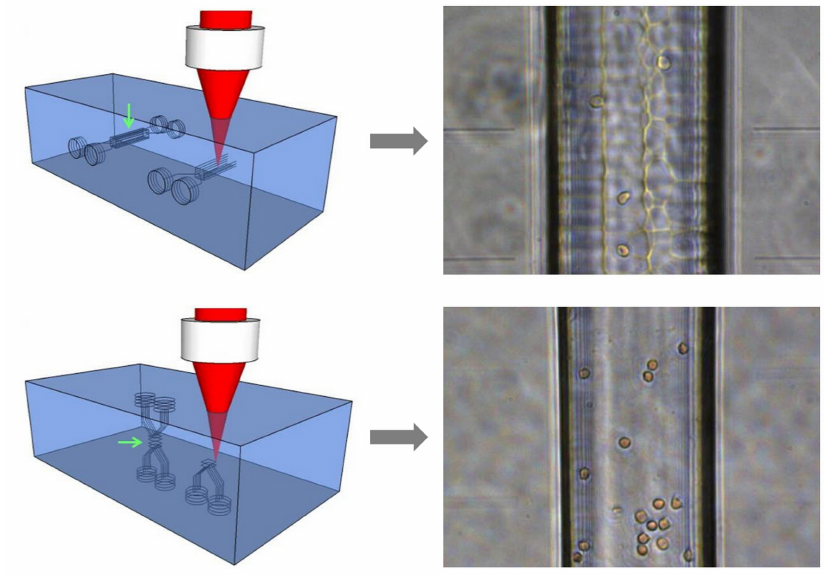
Figure 17. Laser writing geometry optimization for internal channel surface roughness control. Figure reproduced from Reference [24] with permission from Royal Society of